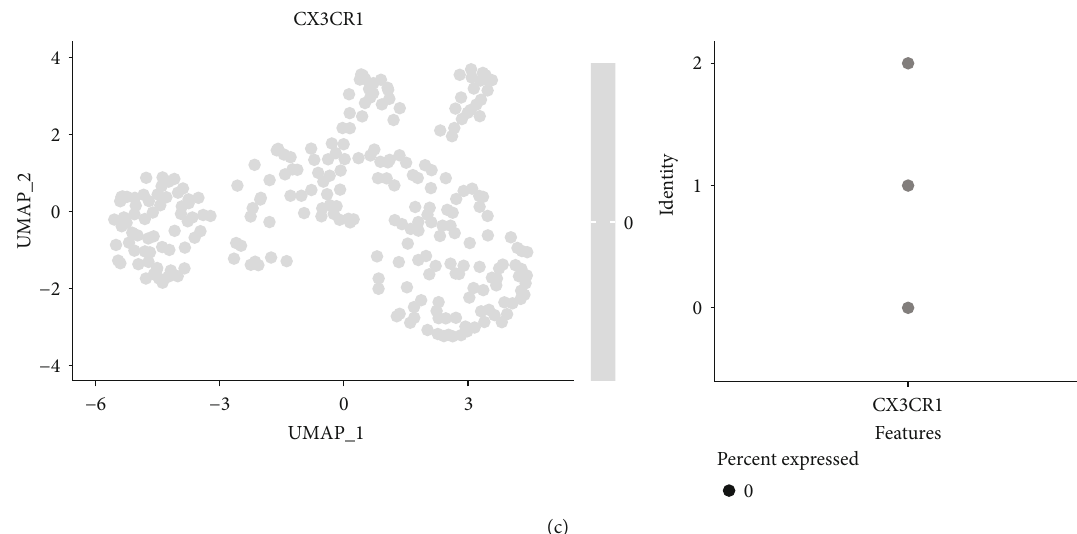
Figure 4: Special features of barrier macrophages in the OA tissue. (a) Dot plots demonstrating the expression pattern and level of expression of M1 or M2 genes. Colour intensities show the expression level of the indicated gene. (b) Dot plots demonstrating the expression pattern and level of expression of barrier macrophages. (c) CX3CR1